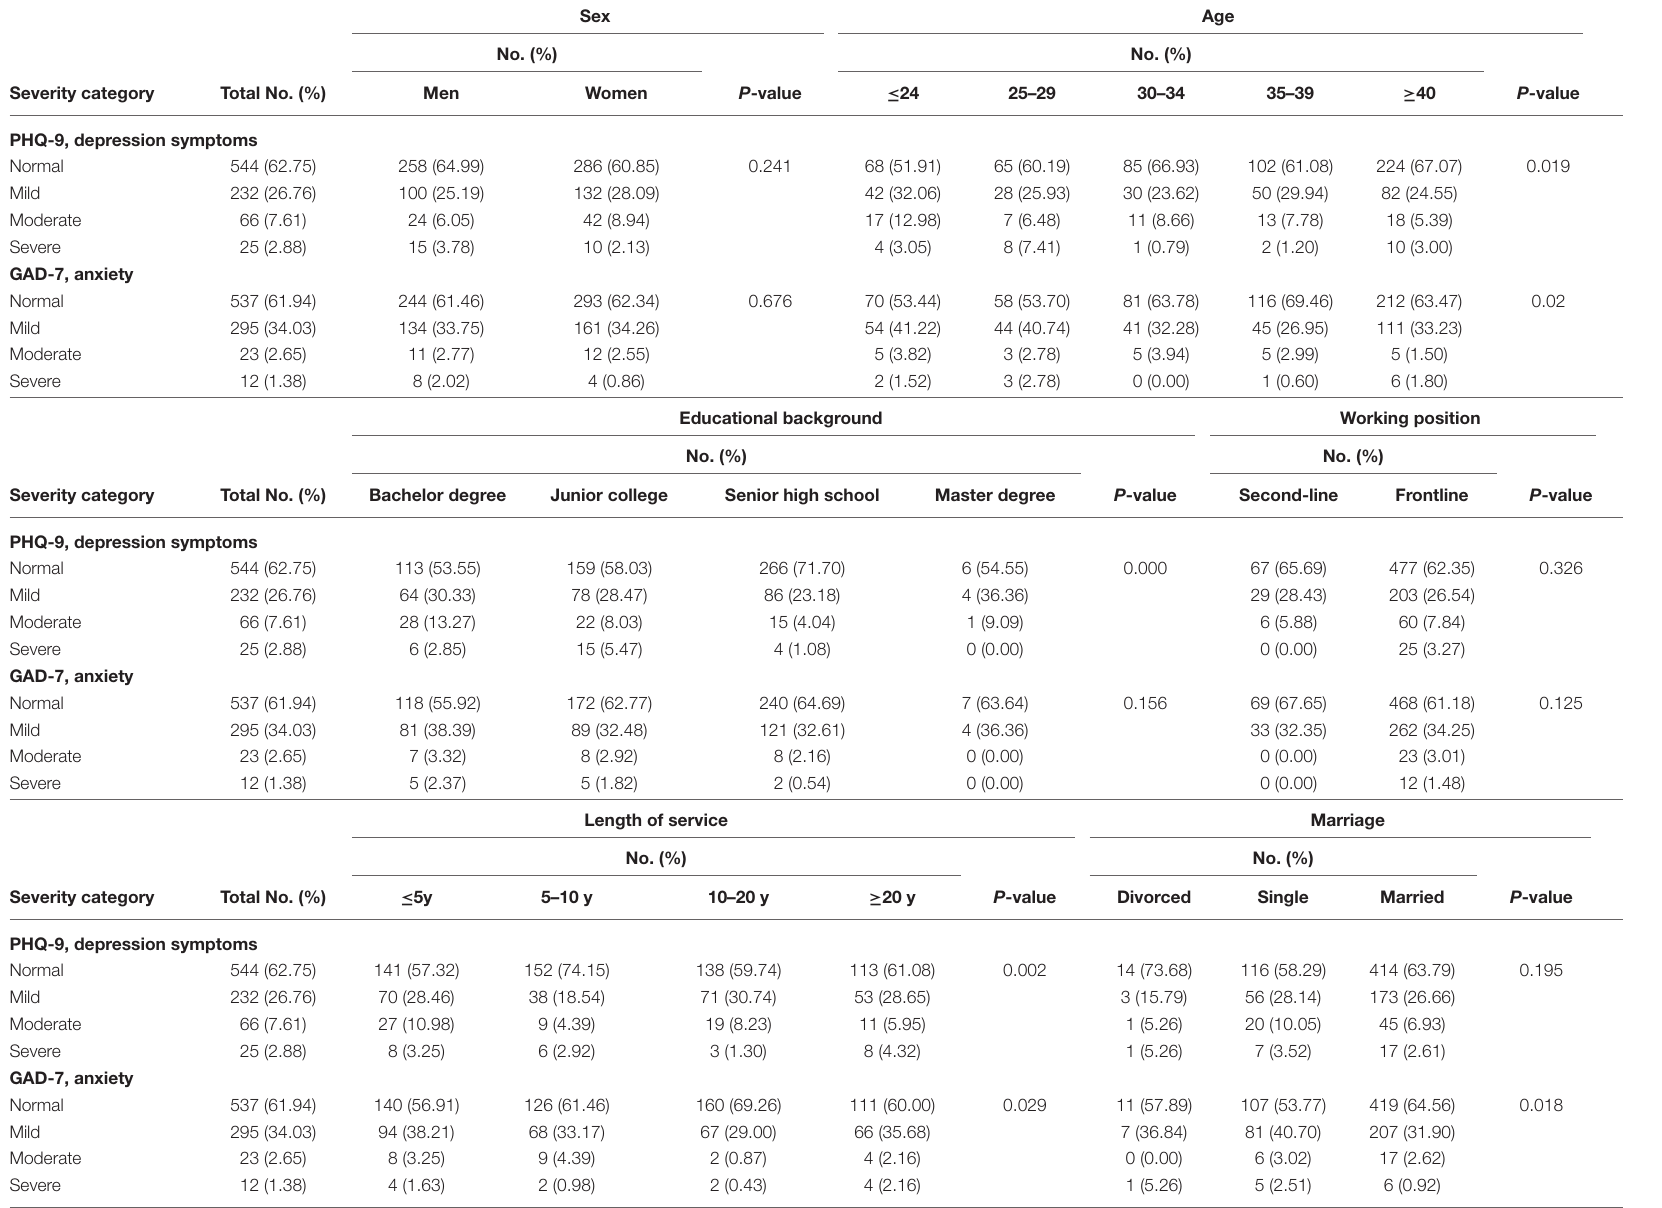
TABLE 2 | Severity categories of depression and anxiety measurements in the total cohort and